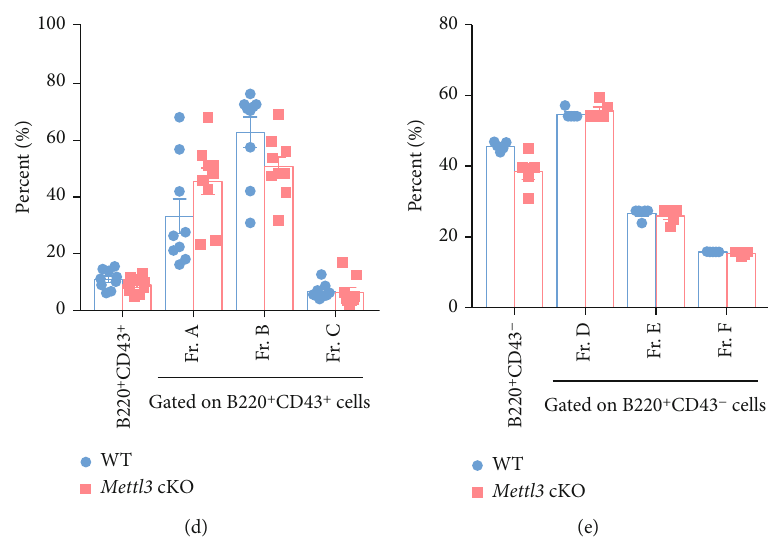
Figure 3: Loss of Mettl3 does not a ff ect B cell development and maturation in bone marrow. (a, b) Representative fl ow cytometry plots (a) and quanti fi cation (b) of B cells in the bone marrow of indicated groups ( n = 4 /group). (c) – (e) Representative fl ow cytometry plots of B cell subpopulations in the bone marrow of WT and Mettl3 cKO mice. B220 + CD43 + lymphocytes were further analyzed for fraction Fr. A (CD24 - BP1 - ), Fr. B (CD24 + BP1 - ), and Fr. C (CD24 + BP1 + ), and B220 + CD43 - lymphocytes were further analyzed for fraction Fr. D (IgM - IgD - ), Fr. E (IgM + IgD - ), and Fr. F (IgM + IgD + ). (d, e) Quanti fi cation of subpopulations in B220 + CD43 + lymphocytes (d) ( n = 9 /group) and B220 + CD43 - lymphocytes (e) ( n = 5 /group). Data in (b, d, and e) were presented as means ± SEM